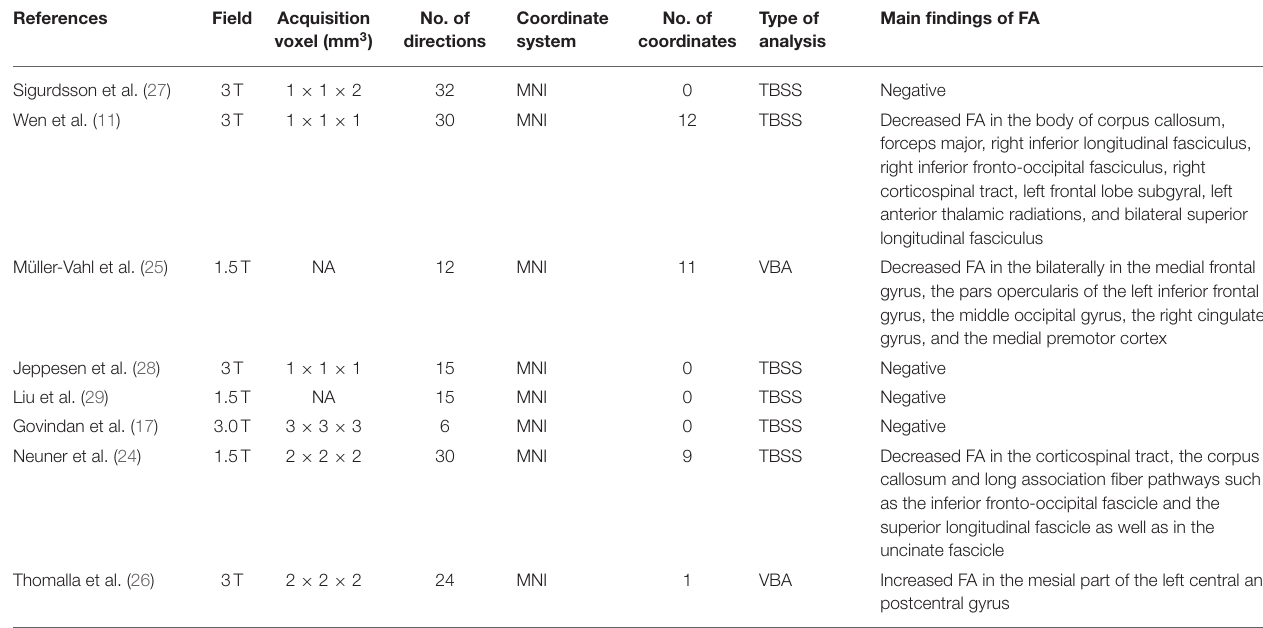
TABLE 2 | Technical details and main findings of the eight studies included in this meta-analysis.